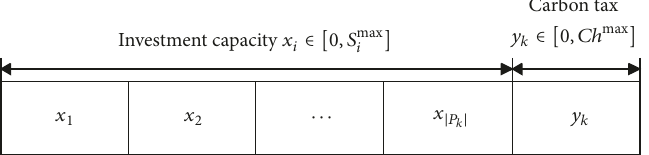
Figure 4: Representation of individual